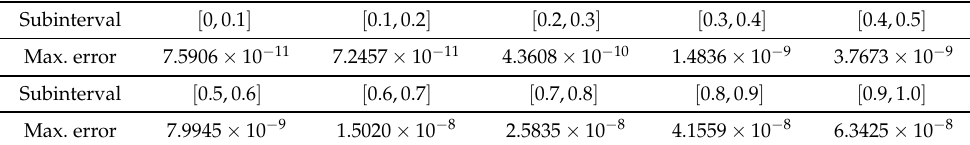
Table 10. Approximation errors for the problem